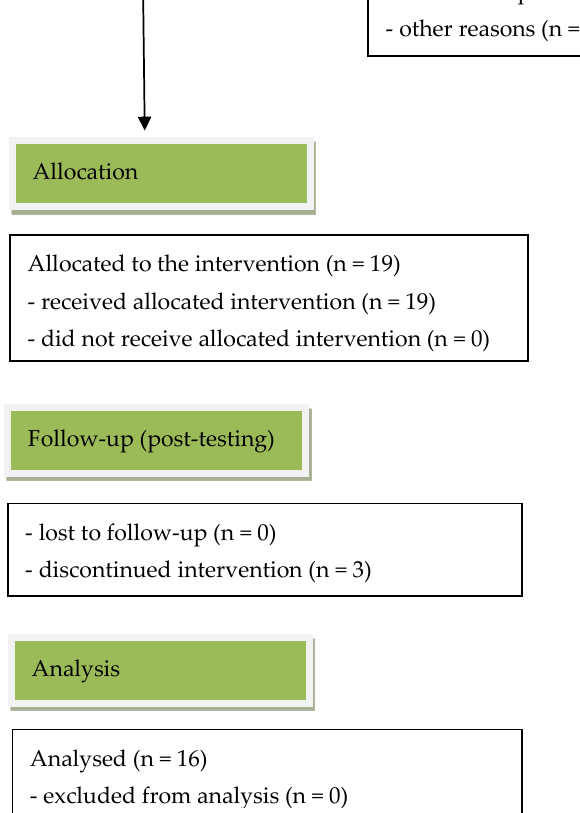
Figure 3. CONSORT flow-diagram: transparent records of participants for the study.